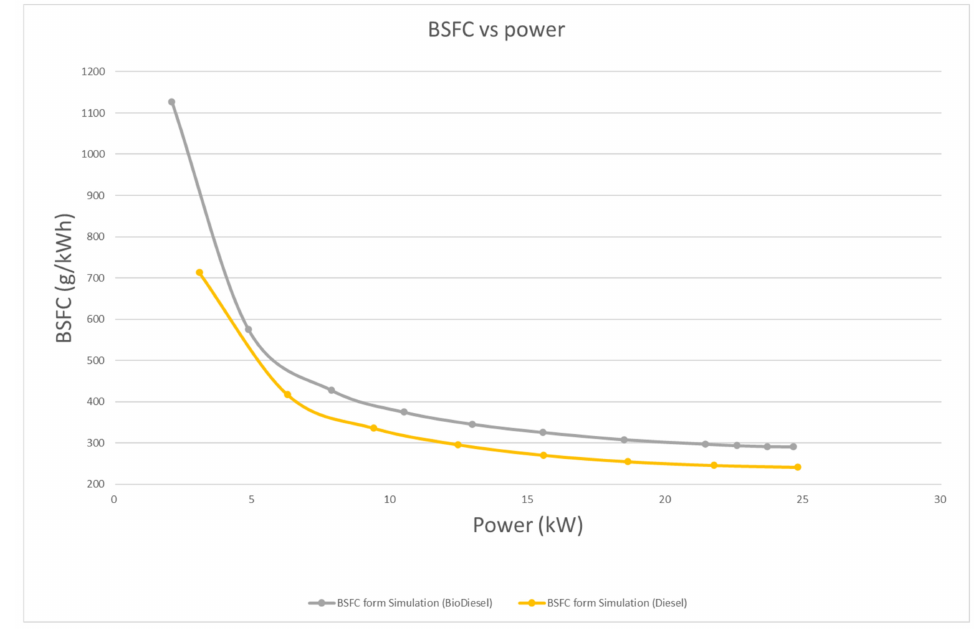
Figure 16. BSFC vs.